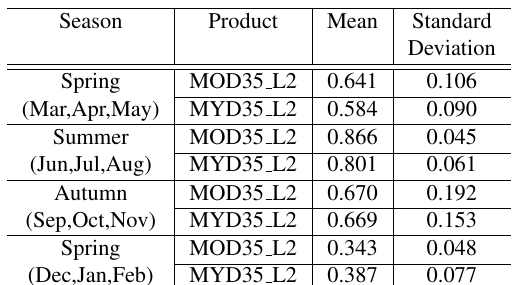
Table 1. Bit fields within first bite